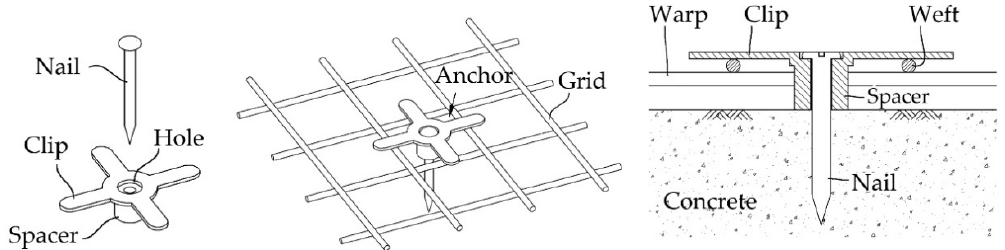
Figure 6. Schematics of a grid anchor system [31–33].